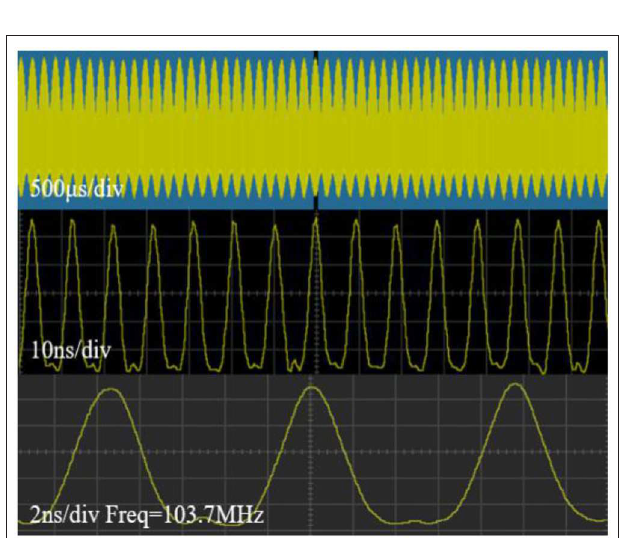
FIGURE 4 | The average output power of continuous wave vs. the pump power.